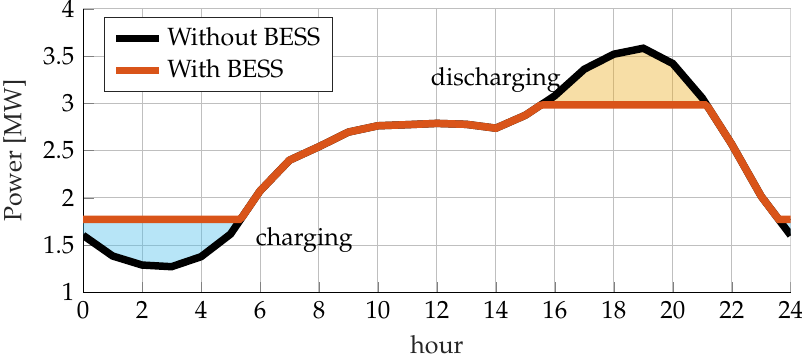
Figure 3. Example of application of the peak shaving strategy for BESS. The energy returned during the day by BESS (orange field) is equal to the drawn energy (blue field) and corresponds to the useful capacity of the energy